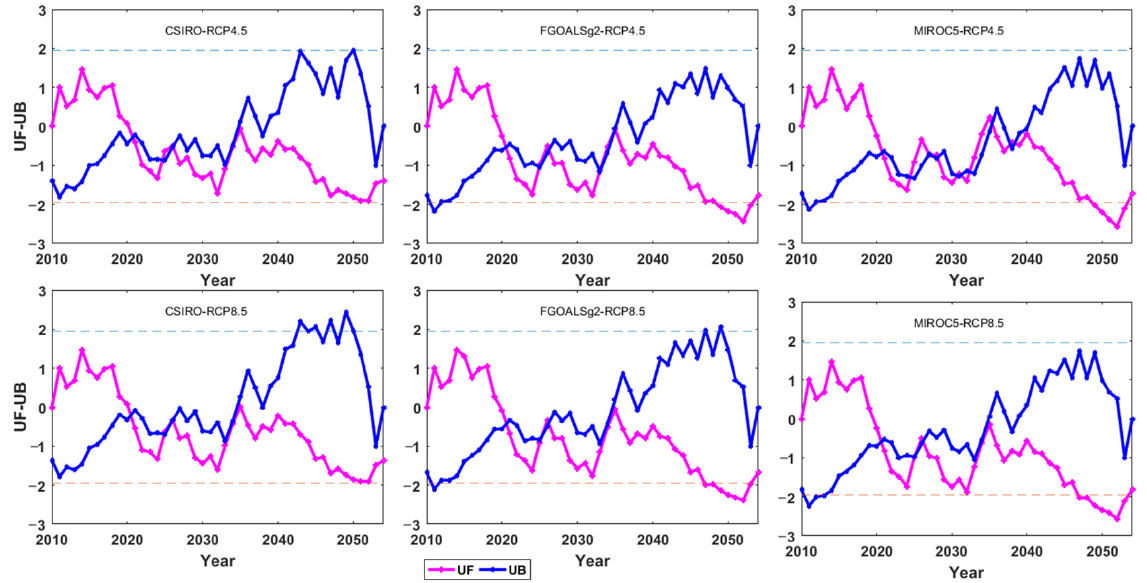
Figure 5. Mann–Kendall test statistics for three GCMs in two scenarios (RCP4.5 and RCP8.5). UF is the sequential values of a statistic under the random hypothesis; UB is the reversed UF data statistic series. The positive and negative values indicate the increasing and decreasing trend. The intersections of UF and UB present the changing point.